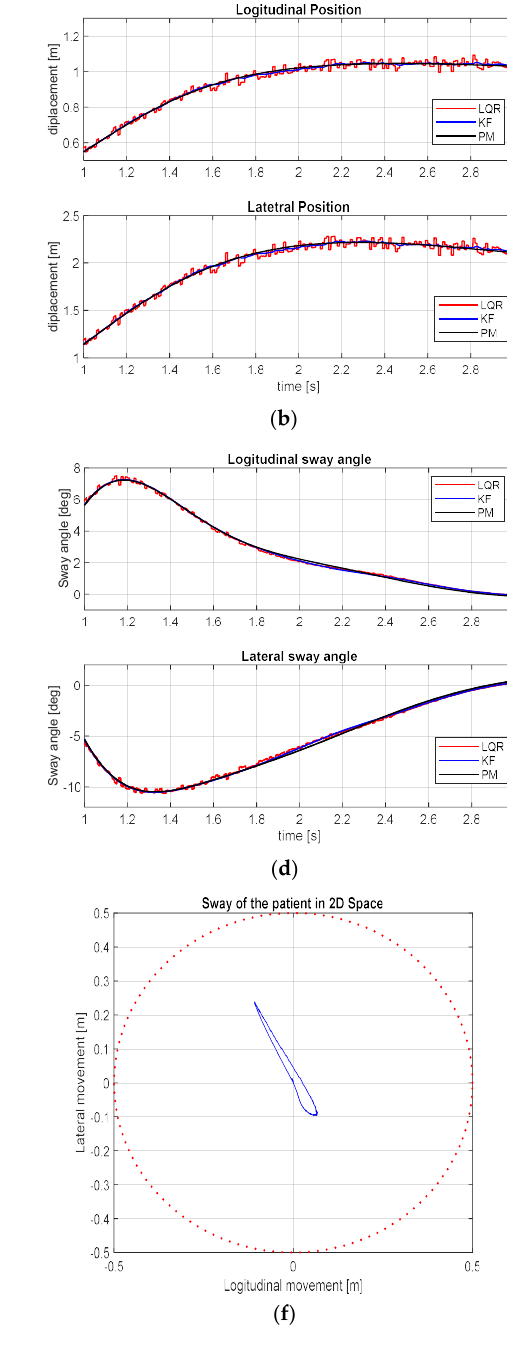
Figure 14. Point-to-point movement results: Longitudinal and lateral movement. ( a ) Overall view; ( b ) enlarged view, longitudinal and lateral sway angles; ( c ) overall view; ( d ) enlarged, displacement of the patient in 2D plane; ( e ) x and y directional movement; ( f ) patient movement in x-y plane. In the 3D pendulum model, when the sway angles in the x and y directions are θ x and θ y , respectively, the displacements in each direction from PTR’s frame are as follows